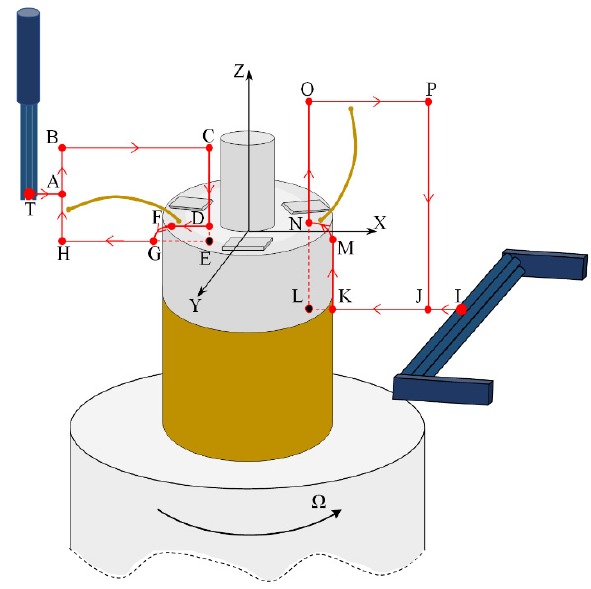
Figure 7. The motion trajectory of the brushing